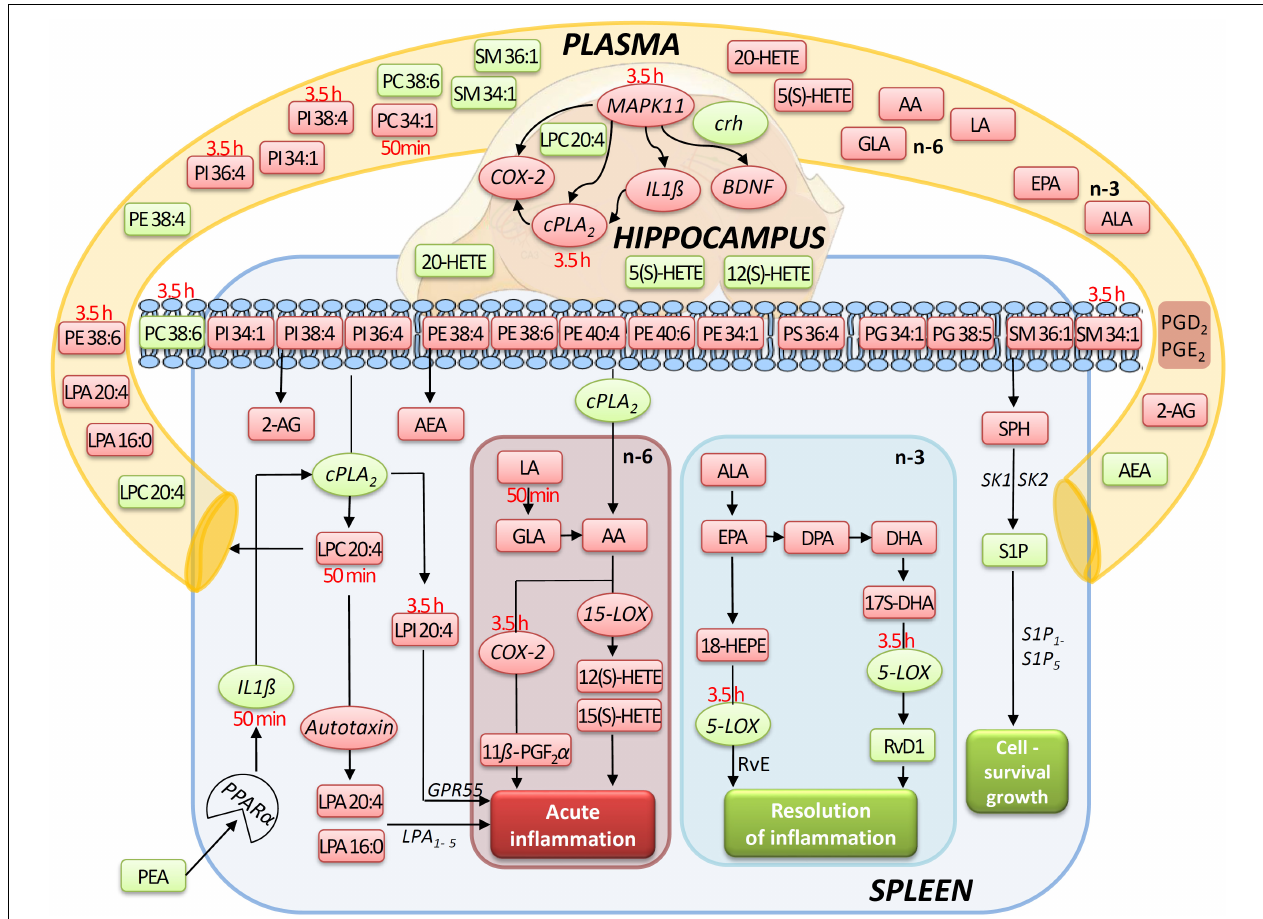
FIGURE 9 | Simplified signaling pathway: this simplified signaling cartoon encompasses all significant molecular changes detected in this study in spleen, hippocampus, and plasma after PEA treatment (PEA/sal). Decreased molecular levels compared to Sal are displayed in red while increased ones in green, respectively. Where lipid level alteration where restricted to a time point, they were specified in red color. The proposed pathways are inferred from published studies that show correlations between the targeted molecules under defined physiological or pathophysiological contexts. This graphic gives also an idea how the PEA-derived splenic molecular phenotype leads to a general state of decreased acute inflammation and increased resolution of inflammation and cell survival/growth. Similarly, possible interrelation between the transcriptional changes (mRNA) by PEA is depicted.